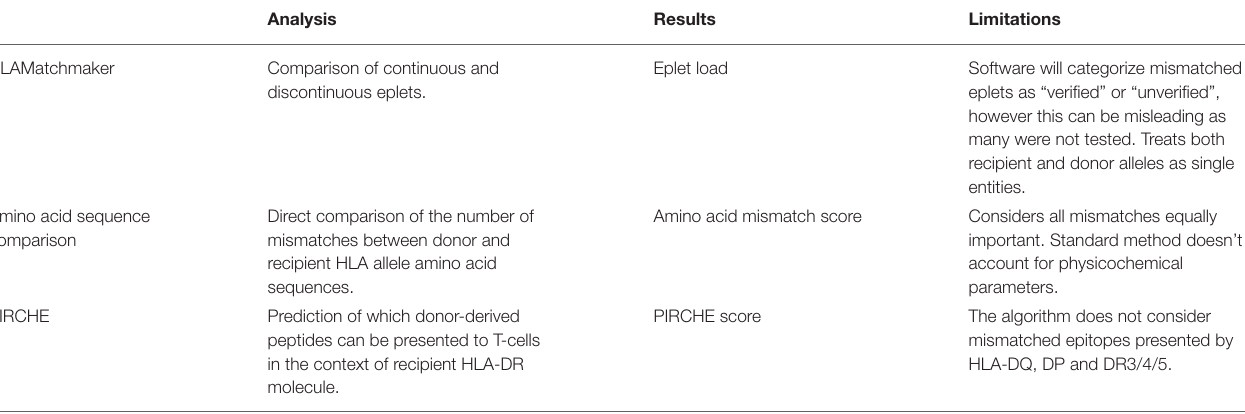
TABLE 1 | Comparison of the three commonly utilized software packages utilized for comparison of donor and recipient HLA types in solid organ transplantation.